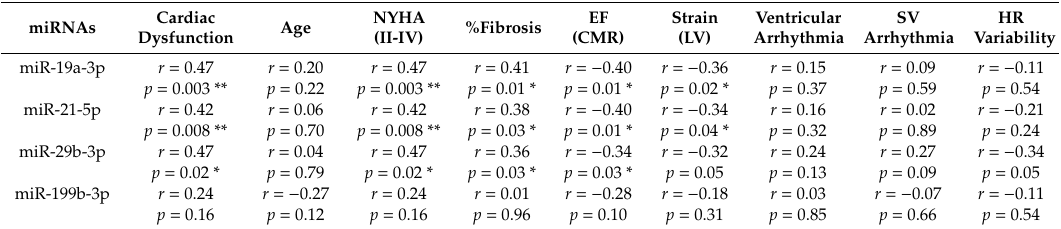
Table 2. Correlation of microRNA expression and clinical parameters in chronic Chagas disease